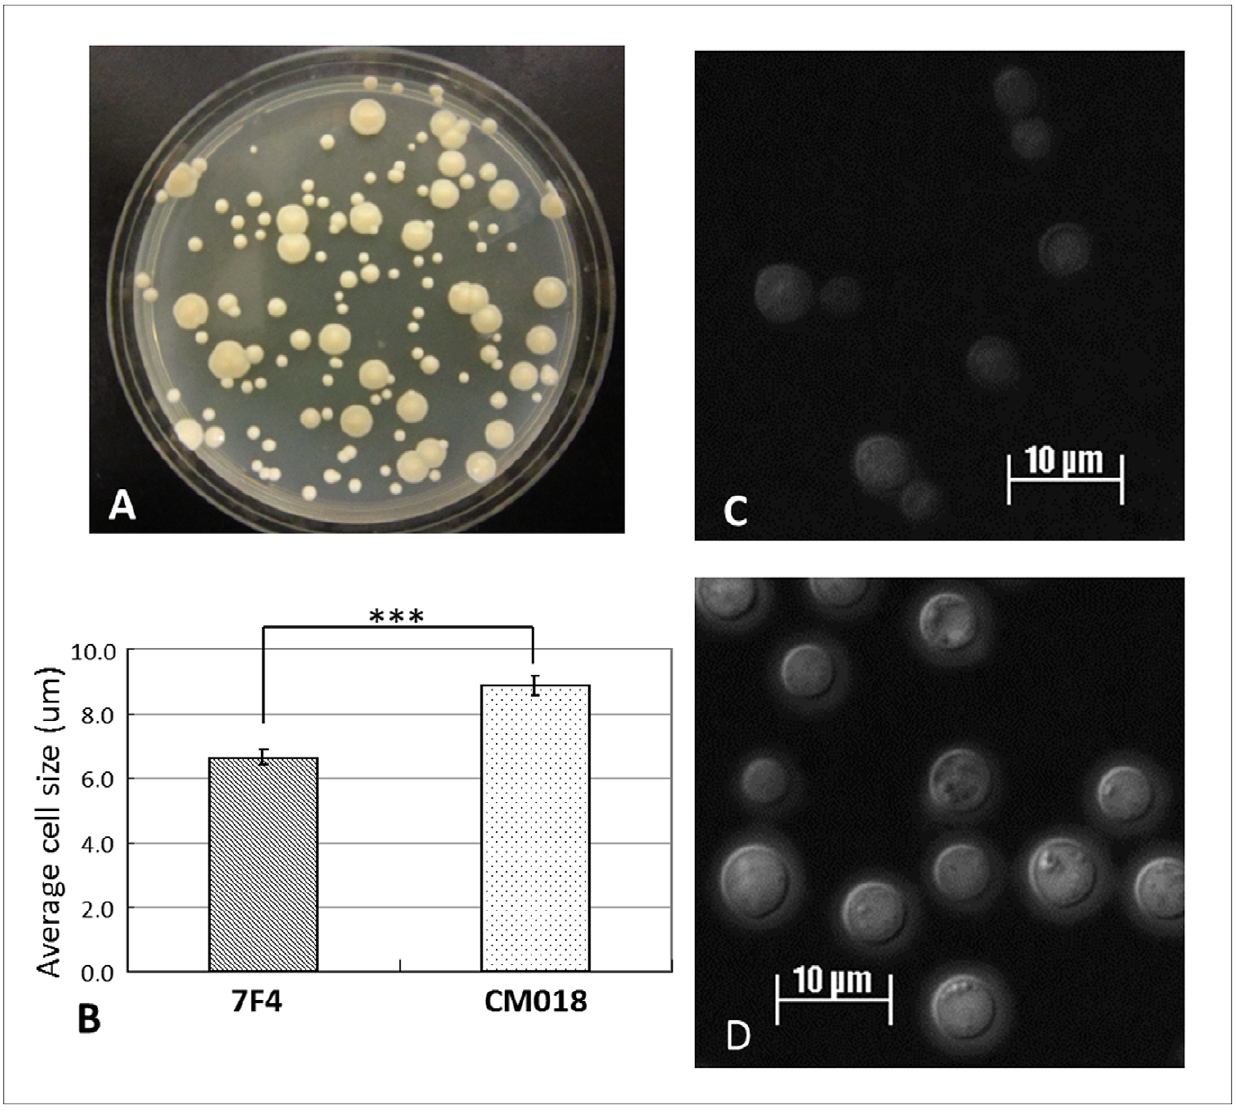
Figure 6. The ‘‘petite’’ cells of 7F4 in comparison with parental strain CMO18. ( A ) The small sizes of 7F4 colonies compared to that of CMO18 in SDA/c culture plate after 4-day growth at 30 u C. ( B ) The unit on y axis is m m, on a 200% adobe photoshop picture, from a 60x Zeiss microscope image. Adobe Photoshop measures in relative units. Total 100 cells examined per strain and total 5 images per strain (differences in diameters P , 0.0001). P value is determined by Student’s t test. ( C ) 7F4 ( rub1 D ) and ( D ) parental strain CM018 with an India Ink stain under oil immersion magnification after 48 hours in Dulbecco’s Modified Eagle Medium (DMEM) at 30 u C shaking incubator.